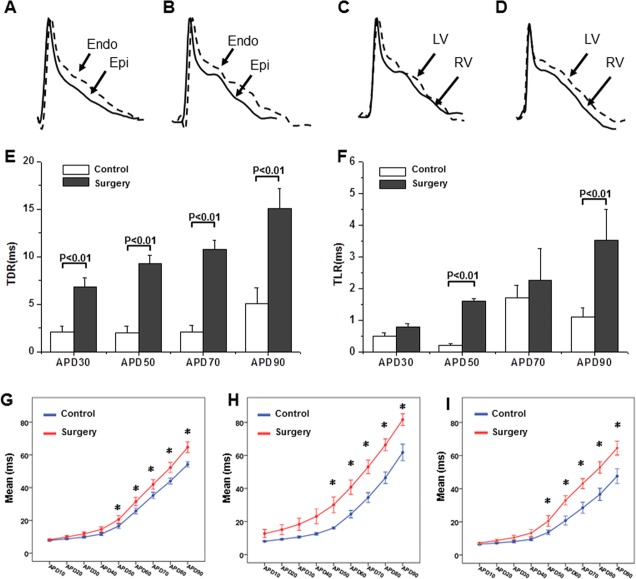
A-B. APD recordings in the endo-myocardium and epi-myocardium in the control (A) and surgery groups (B); C-D. APD recordings in the left and right epi-myocardia in the control (C) and surgery (D) groups; E. The transmural dispersion of repolarization (TDR) in the control and surgery groups; F. Trans-epicardial dispersion of left and right ventricular repolarization (TLR) in the control and surgery groups; G. APD recordings in the endo-myocardium between the control and surgery groups; H. APD recordings in the epi-myocardium between the control and surgery groups; I. APD recordings in the right ventricle between the control and surgery groups.